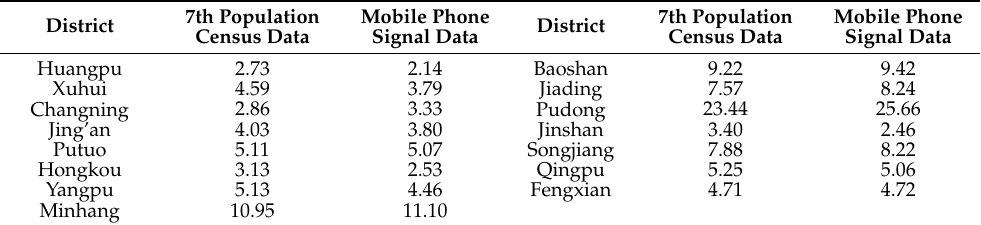
Table 2. Population distribution in the districts of Shanghai (%).